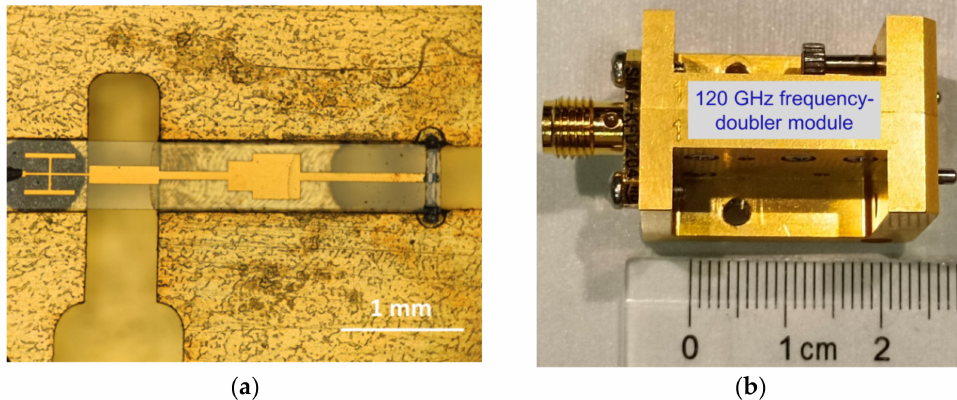
Figure 7. ( a ) The optical micrograph of 120 GHz frequency doubler imbedded in the split-waveguide block. ( b ) Overall photograph of the 120 GHz frequency-doubler module.